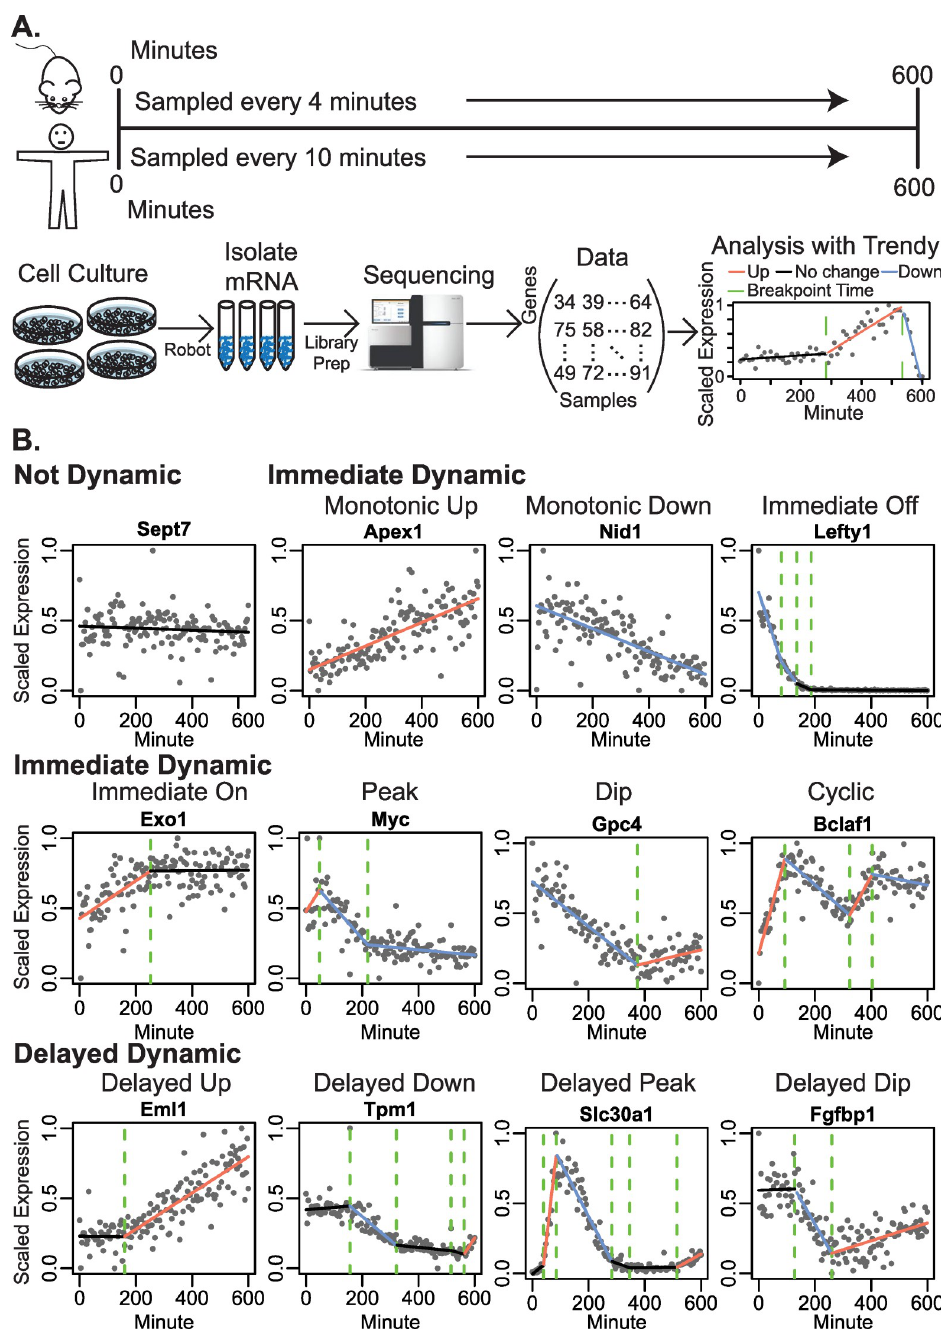
Fig 1. Experiment overview and expression patterns. A) Mouse and human pluripotent stems cells were exposed to neural differentiation factors to initiate differentiation and then sampled for RNA-sequencing every 4 or 10 minutes for the first 600 minutes. Expression trends along the time course for each gene were fit using a breakpoint model. B) Expression trends are shown for representative genes having patterns classified as not dynamic, immediate dynamic, or delayed dynamic. Immediate dynamic genes had an immediate up- or downregulation segment, whereas delayed dynamic genes had a flat initial segment. Trends were further characterized as having a peak, dip, or as cyclic (multiple peak/dip)